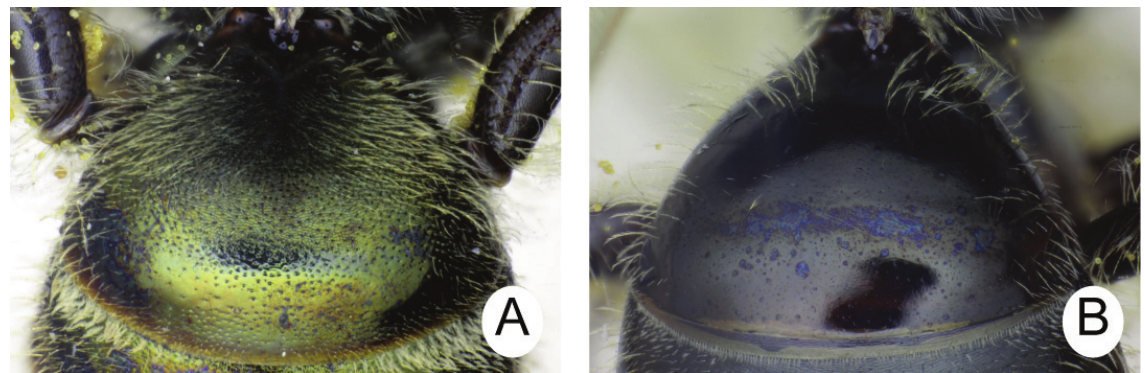
Fig. 24. Photographs for keys: T1 of female. A . Lasioglossum ( Dialictus ) viridellum (cockerell, 1931). B . L . ( D .) virideglaucum ebmer & Sakagami, 1994.